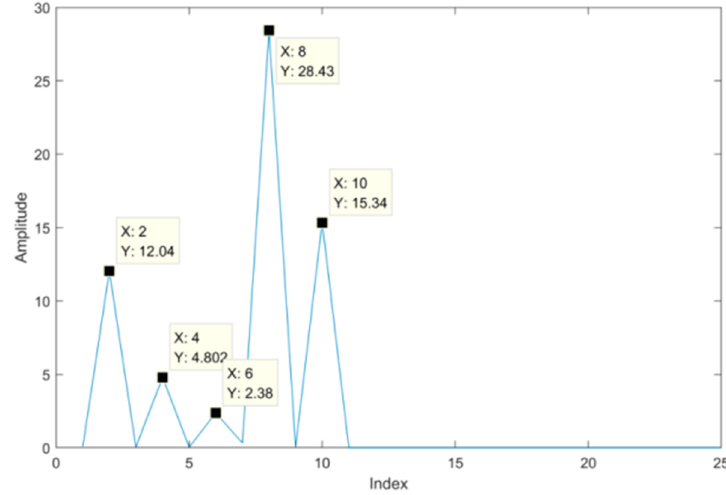
Figure 13. Difference spectrum of singular values for the bearing signal with strong noise.